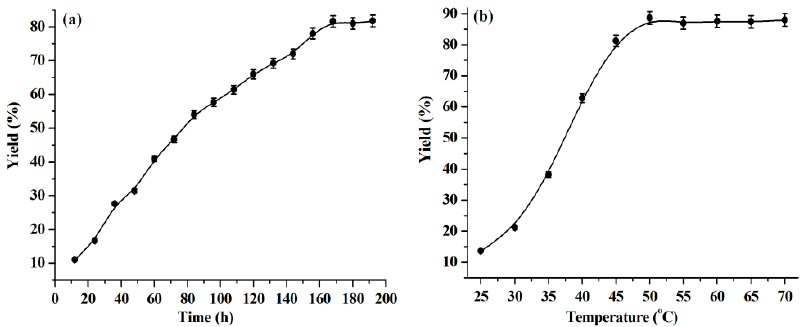
Figure 2. Influence of reaction time ( a ) and temperature ( b ) on the warfarin yield. Reaction conditions: